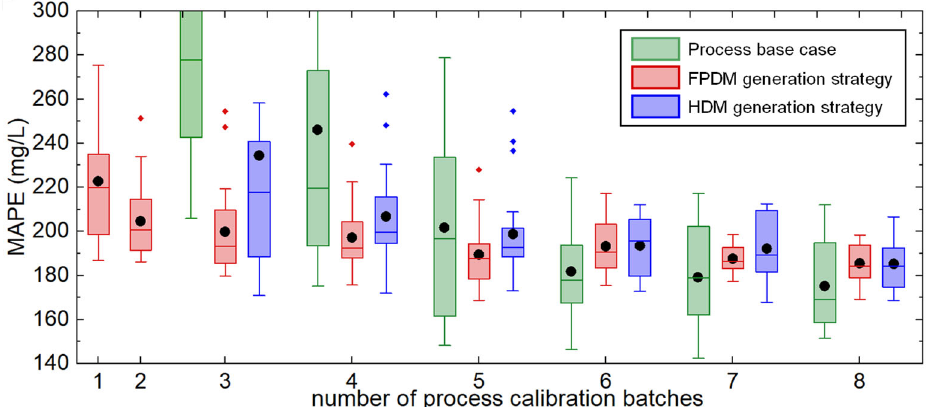
Figure 6. Validation estimation performance comparison: MAPE distribution profiles from a 20-repetitions validation in the estimation of mAbs titer at harvest through MPLS. Green boxes—process base case; red boxes—FPDM data augmentation strategy; blue boxes—HDM data augmentation strategy. The boxes represent the 25 ◦ and 75 ◦ percentile and the median value, the dots represent the mean value of the MAPE, the error bars represent the 95% confidence intervals, and the diamonds are errors outside the 95% confidence